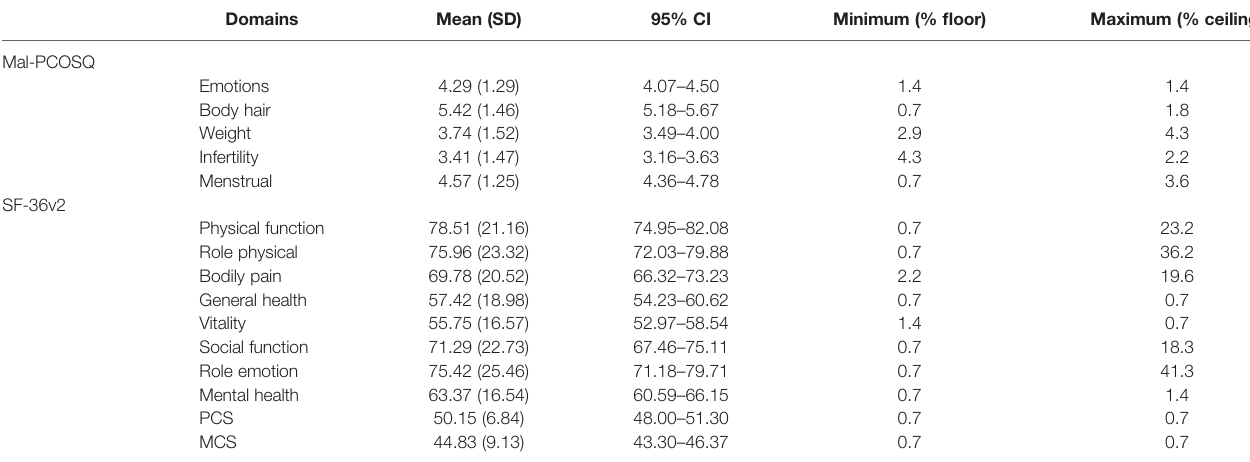
PCS, physical component score; MCS, mental component score.